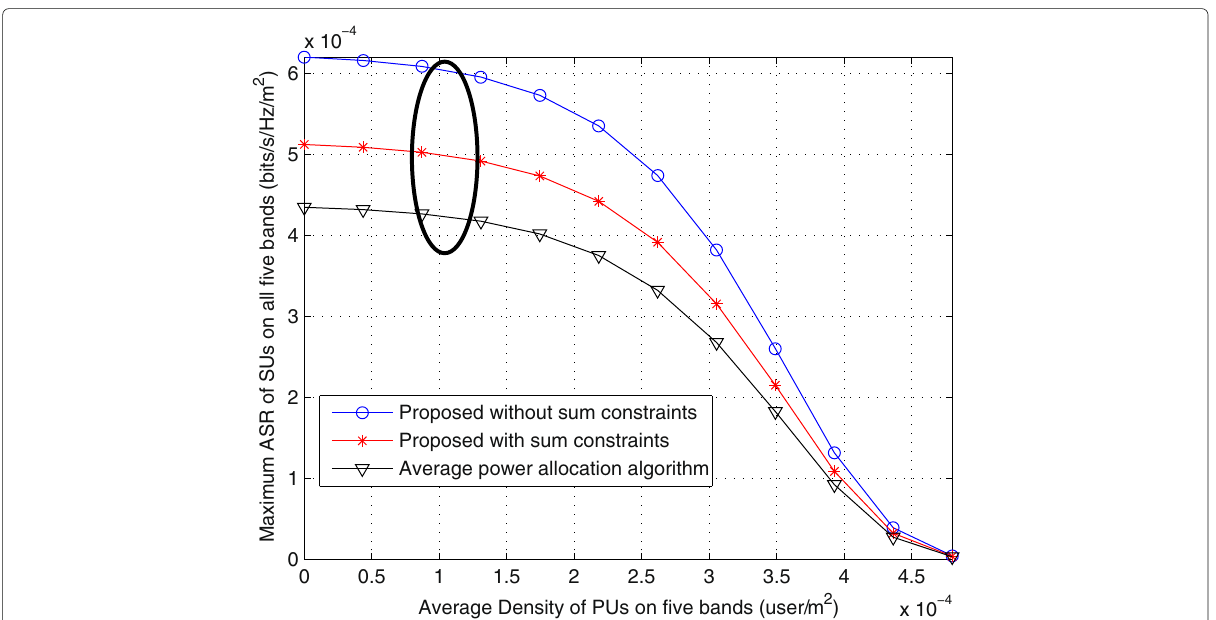
Fig. 10 Maximum ASR of SUs vs. average density of PUs on all five